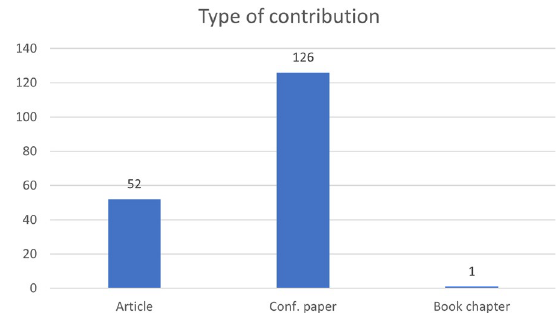
Fig. 2 Type of contributions: number of papers by type 1 1 Conference categorization and ranking based on the GII-GRIN-SCIE